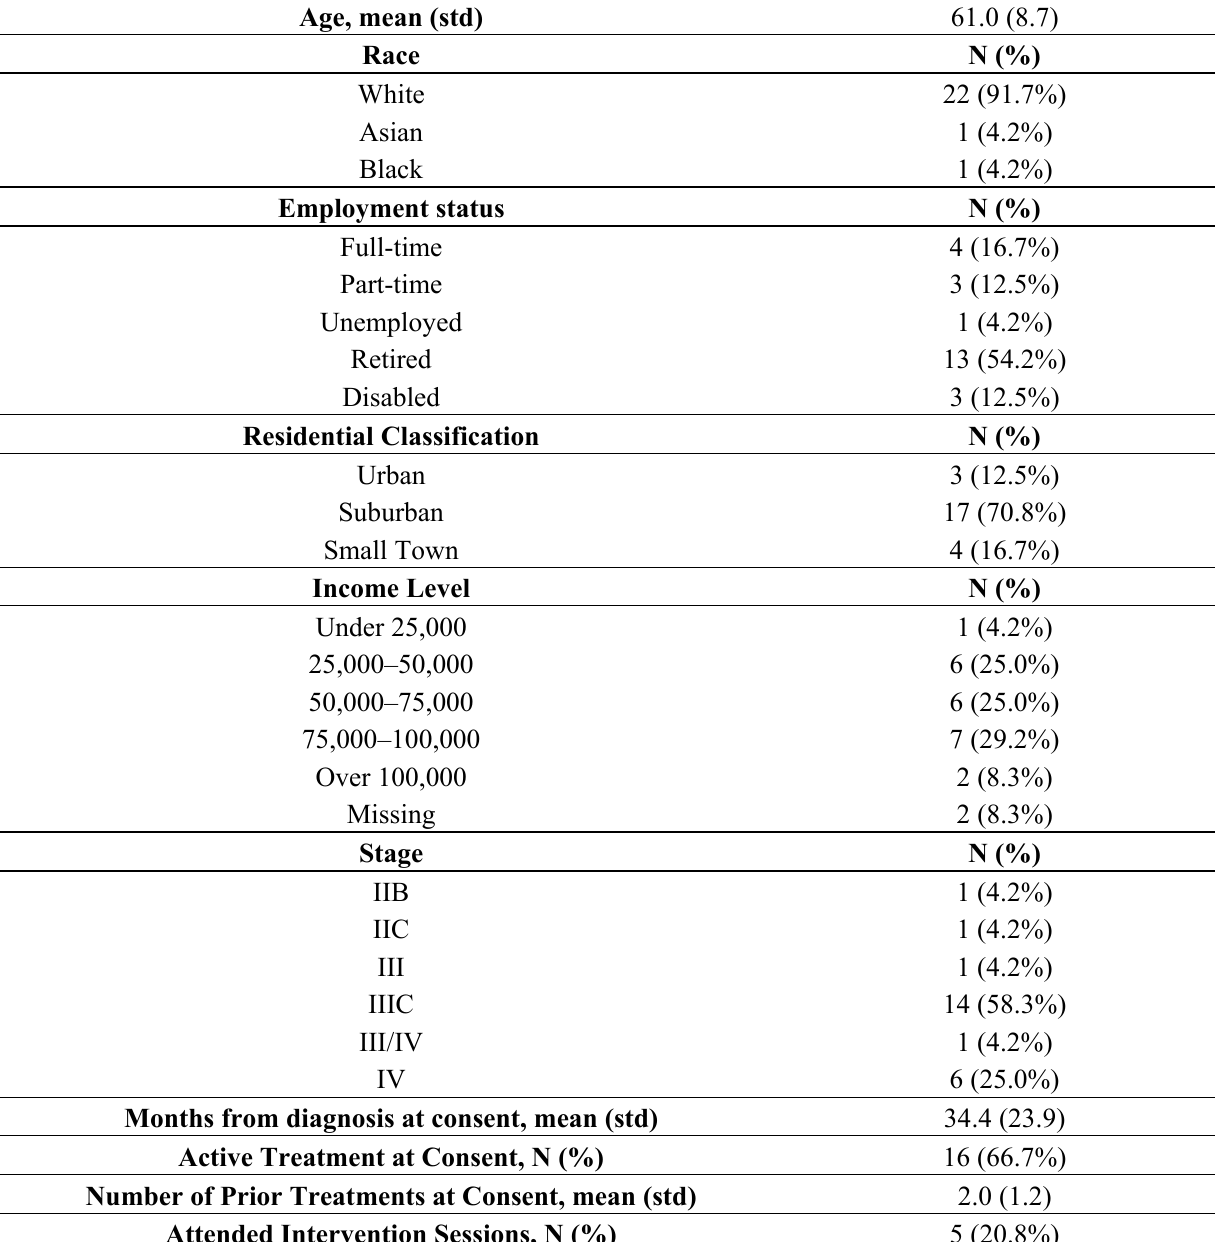
Table 2. Descriptive characteristics of participants who completed the baseline